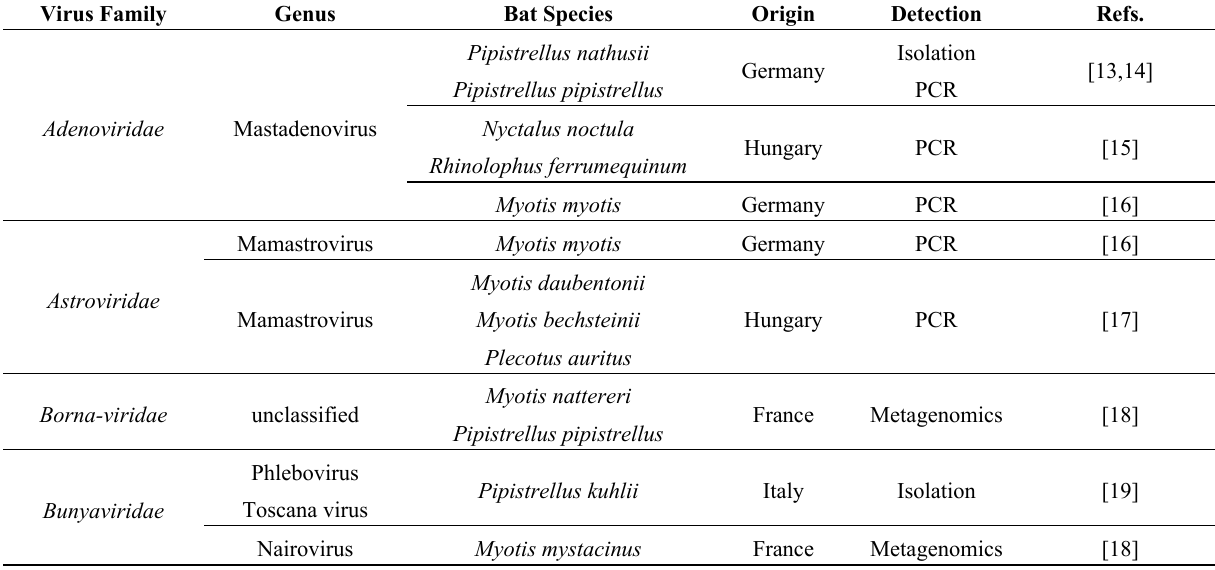
Table 1. Viruses of European